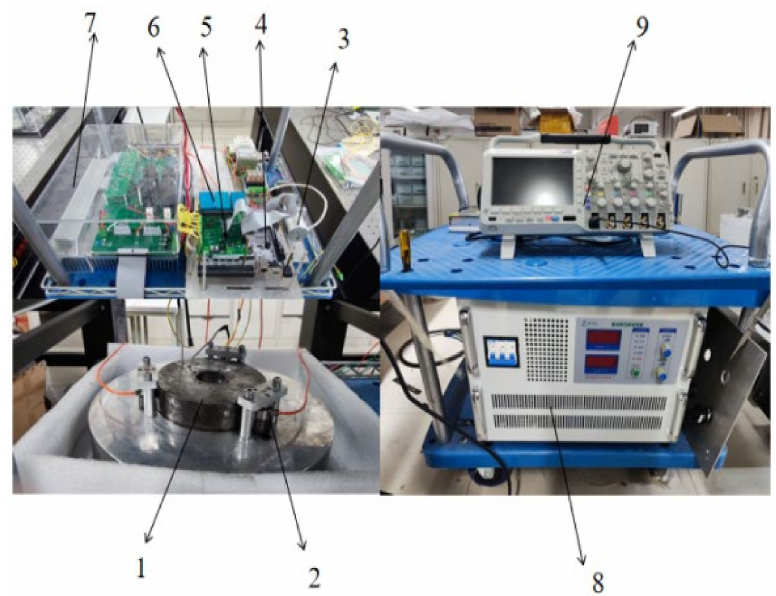
Figure 13. Hardware in the loop simulation experiment platform: 1—electromagnet; 2—pressure sensor; 3—DC motor; 4—controller; 5—signal acquisition board; 6—pressure transmitter; 7—drive circuit; 8—DC power supply;